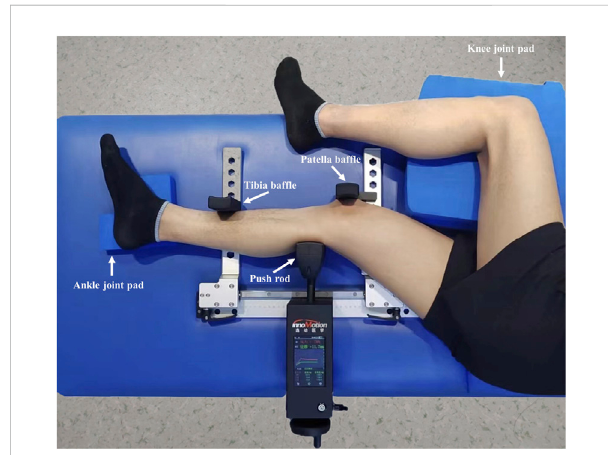
FIGURE 2 The measurement of anterior knee laxity by the Ligs Digital Arthrometer.